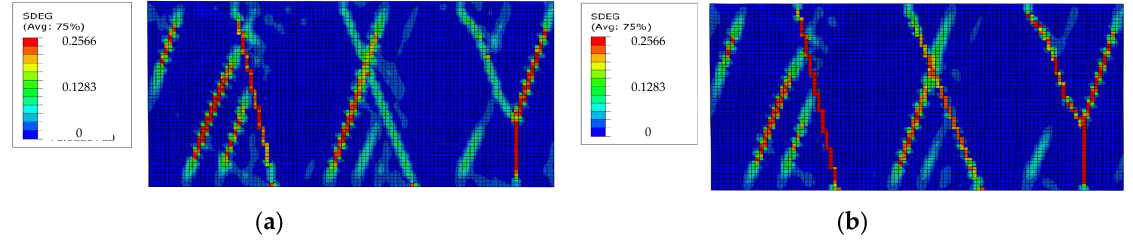
Figure 7. Plane view of contour of damage variable with α = 1 5° and ε22 = 0.024: ( a ) contour of damage SDEG at T74 interface, and ( b ) contour of SDEG at T76